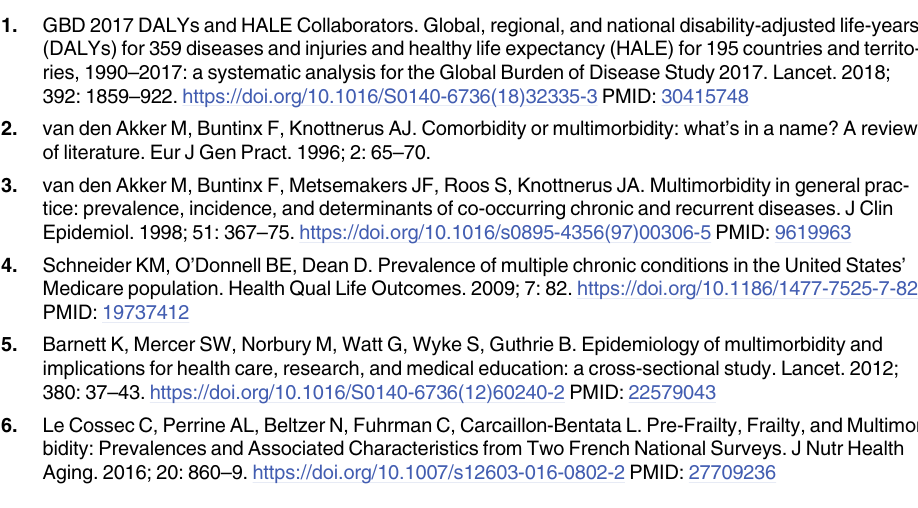
S10 Table. Impact of associated conditions (triads and tetrads) on activity limitations and perceived health in the ESPS and HSM surveys. S11 Table. Joint effects of dyads of associated conditions on activity limitations (severely limited in GALI, limited in � 3 ADLs or � 2 IADLs, new limitation) and perceived health (bad or very bad SRH, new health deterioration) in the ESPS and HSM surveys when the conditions were retained in the final models presented in Table 1. S12 Table. Joint effects of two-by-two associated conditions within triads on activity limi- tations and perceived health in the ESPS and HSM surveys when the conditions were retained in the final models presented in Table